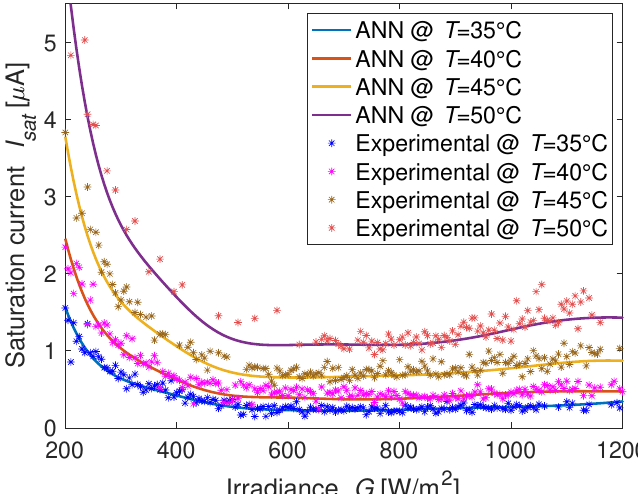
Figure 7. ANN identification of the saturation current in healthy